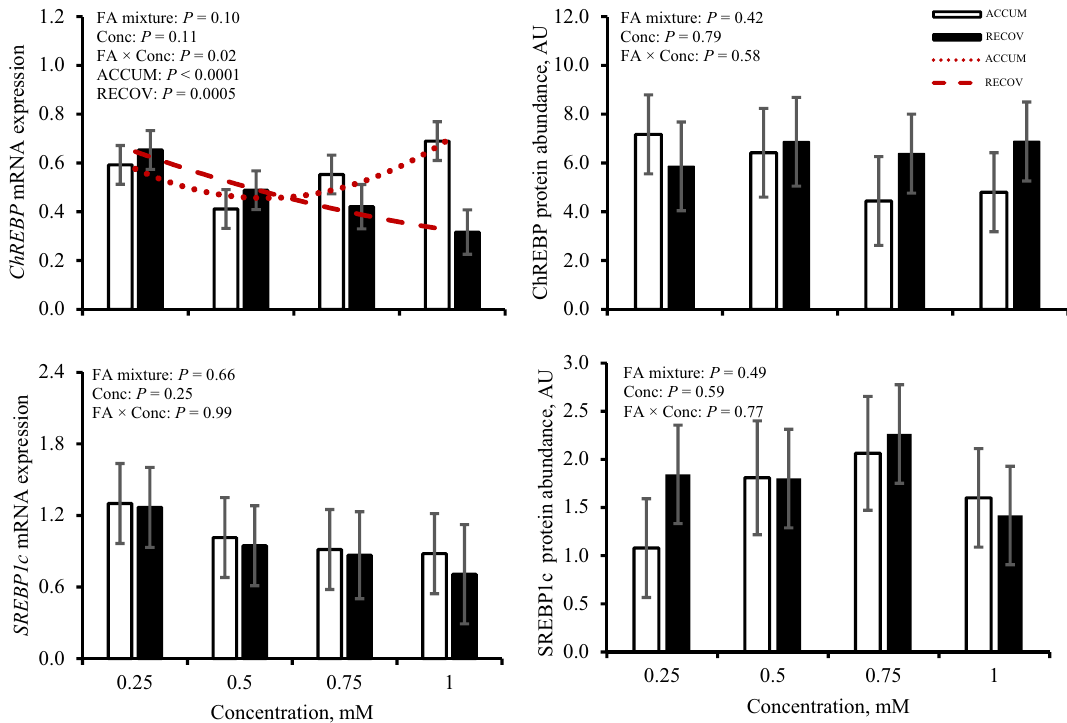
Figure 6. Gene expression and protein abundance of carbohydrate response element binding protein (ChREBP) and sterol regulatory element-binding transcription factor 1c (SREBP1c) in response to fatty acid mixture representing liver lipid accumulation (ACCUM; open bars and dotted line) and fatty acid mixture representing liver lipid clearing (RECOV; closed bars and dashed line) at different concentrations in primary bovine hepatocytes. Data is presented as least squares mean ± standard error of the means. Quadratic relationships are displayed if P ≤ 0.15 for a main